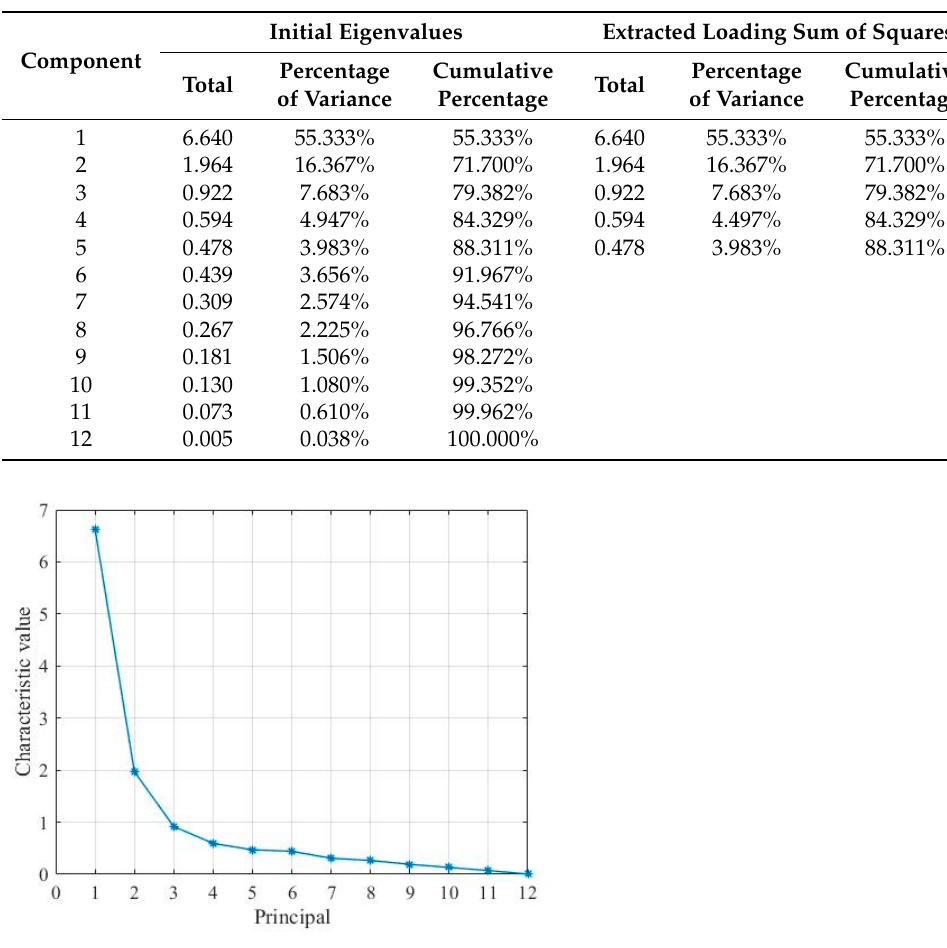
Table 8. Interpretation of total variance of each principal component.